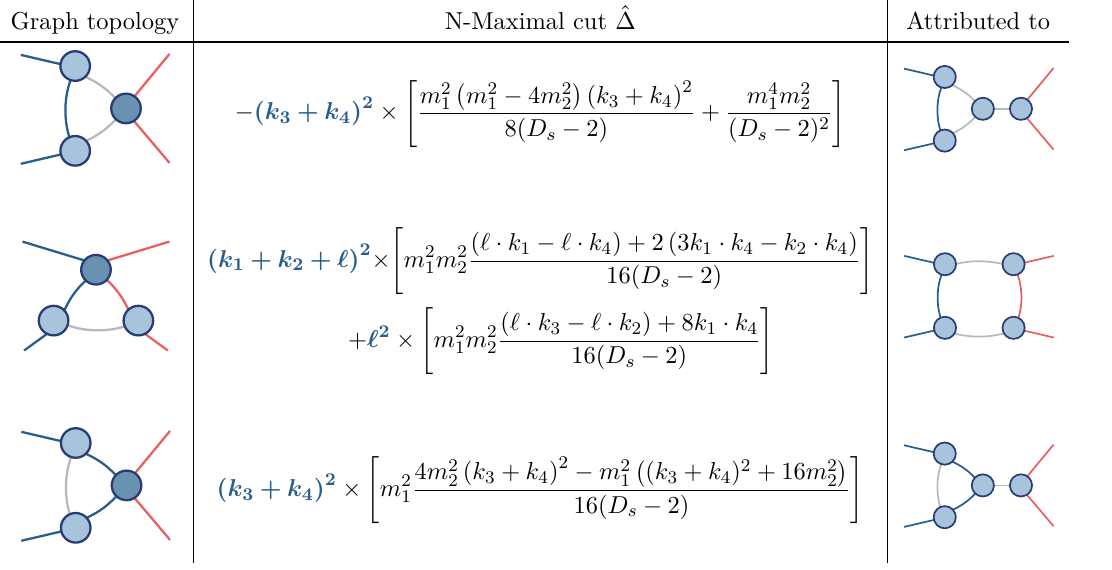
Table 5 . The symmetrized ˆ∆ contributions from the well-defined next-to-maximal cuts of the one-loop four-point amplitude attributed to inverse propagators. Light blue blobs represent three- point amplitudes, darker blobs represent four-point amplitudes and exposed legs represent on-shell